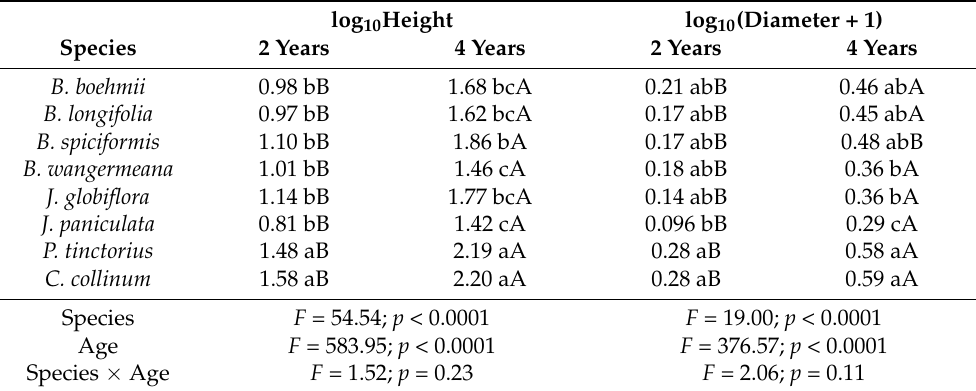
Table A2. Analysis of variance on the effects of age and species on height (standard error = 0.075, N = 48) and diameter of the stem at collar level (Diameter, standard error = 0.037, N = 48). log 10 Height